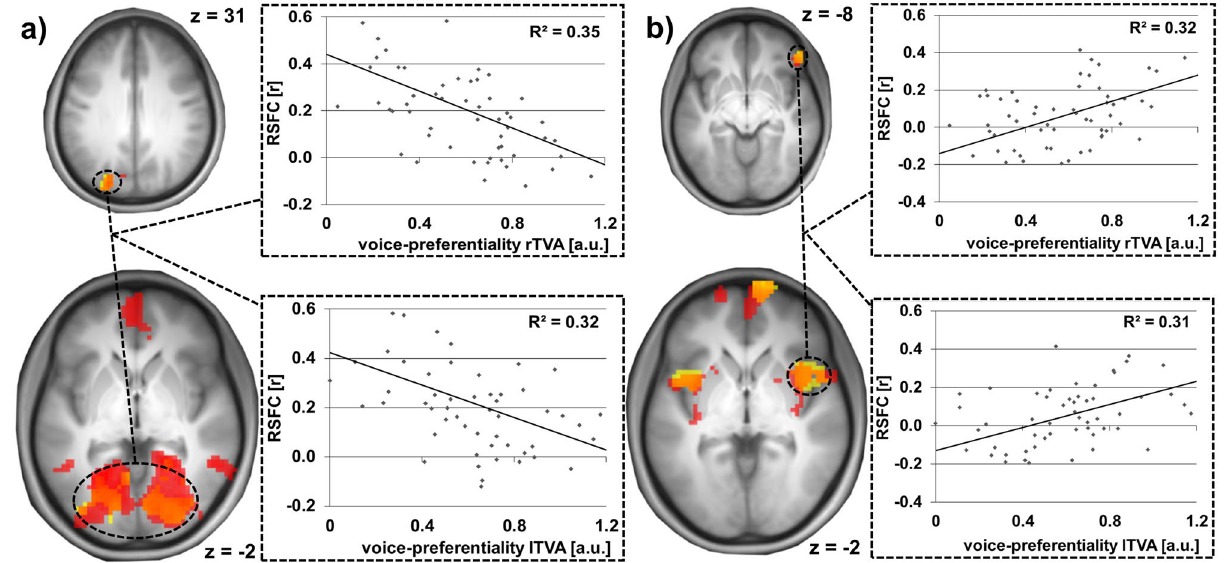
Figure 3. Convergence of informative RSFC patterns for bilateral TVA voice-preferentiality using ( a ) the left superior occipital gyrus and ( b ) the right inferior orbital gyrus as seed region. Top brain section: Exemplary MVPA cluster informative of right and left TVA voice-preferentiality used as seed region [see also Fig. 2b,c]. Bottom brain section: The seed’s convergent informative RSFC patterns regarding individual voice-preferential responses of the right (red) and left (yellow) TVA (orange: overlap of informative patterns for right and left TVA voice-preferentiality) as evaluated post hoc. Results shown at a voxel-wise threshold of p < 0.001 and whole brain FWE-corrected at cluster level with a cluster threshold of p < 0.05. Coordinates refer to MNI space. The diagrams on the right illustrate the underlying association of voice-preferential responses and